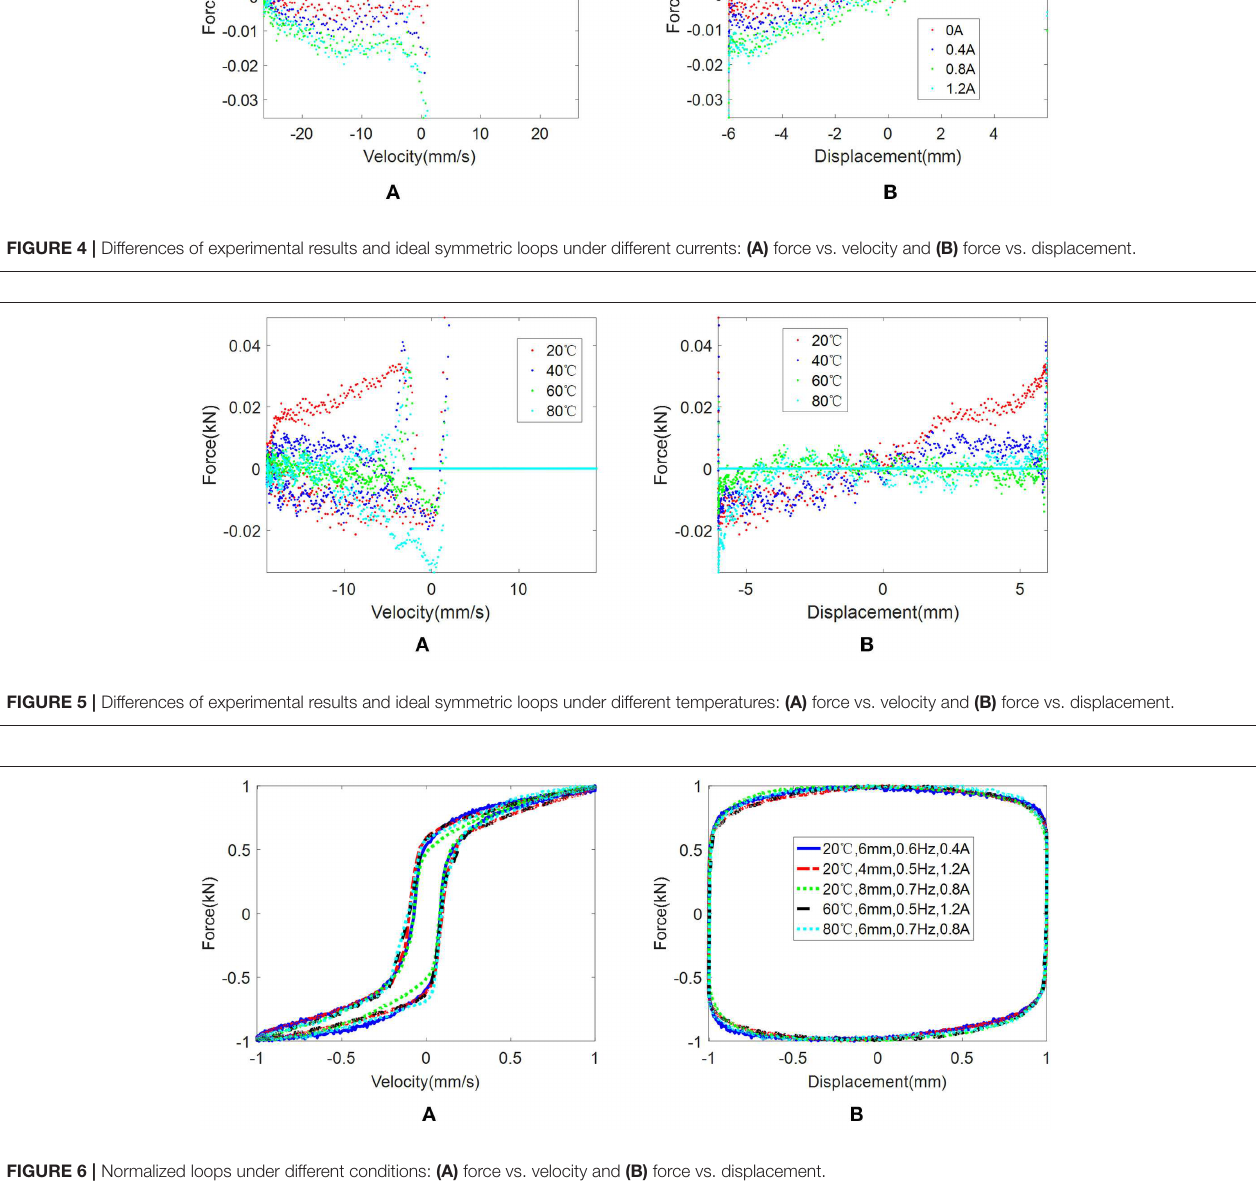
Frontiers in Materials |